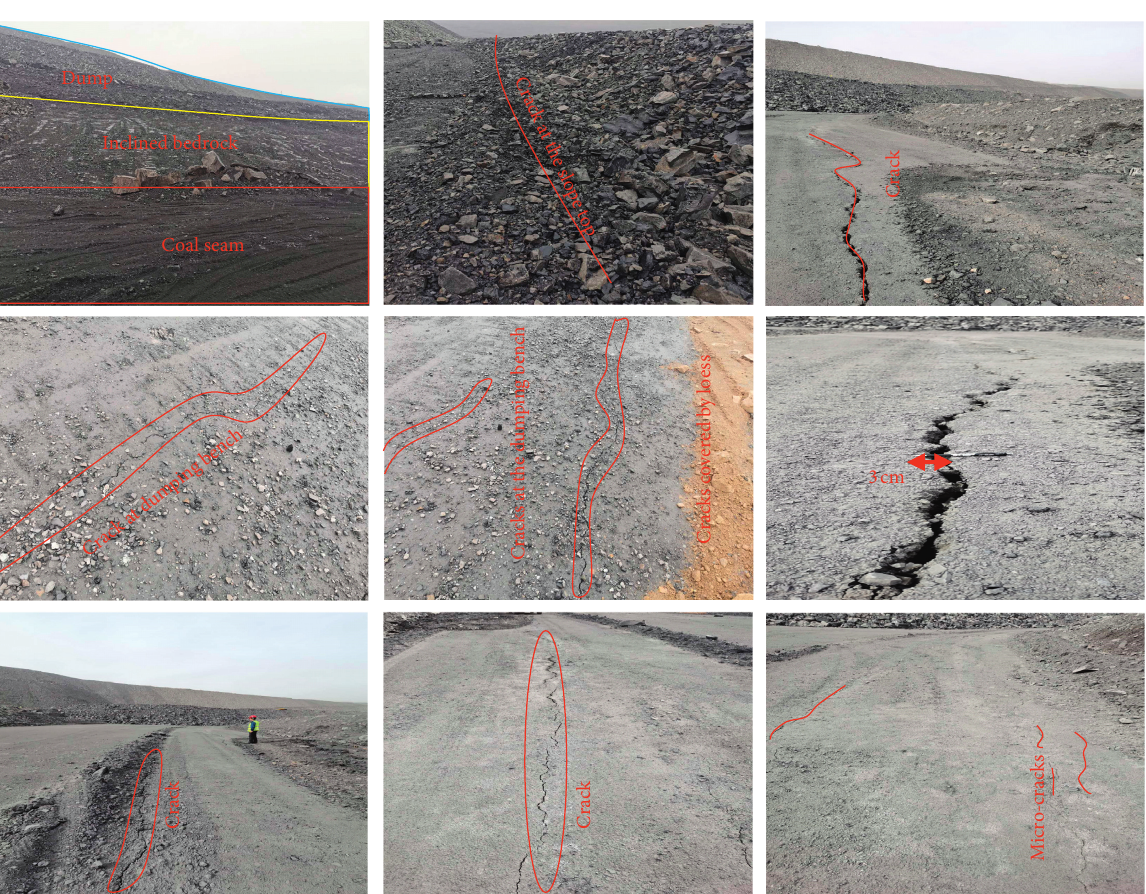
Figure 14: Cracks of dump at large inclined